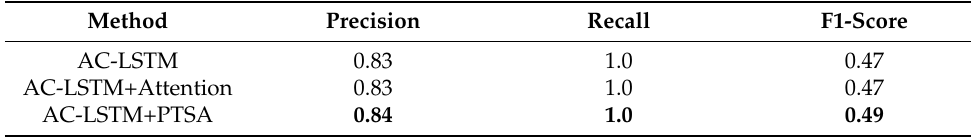
Table 3. The effect of attention